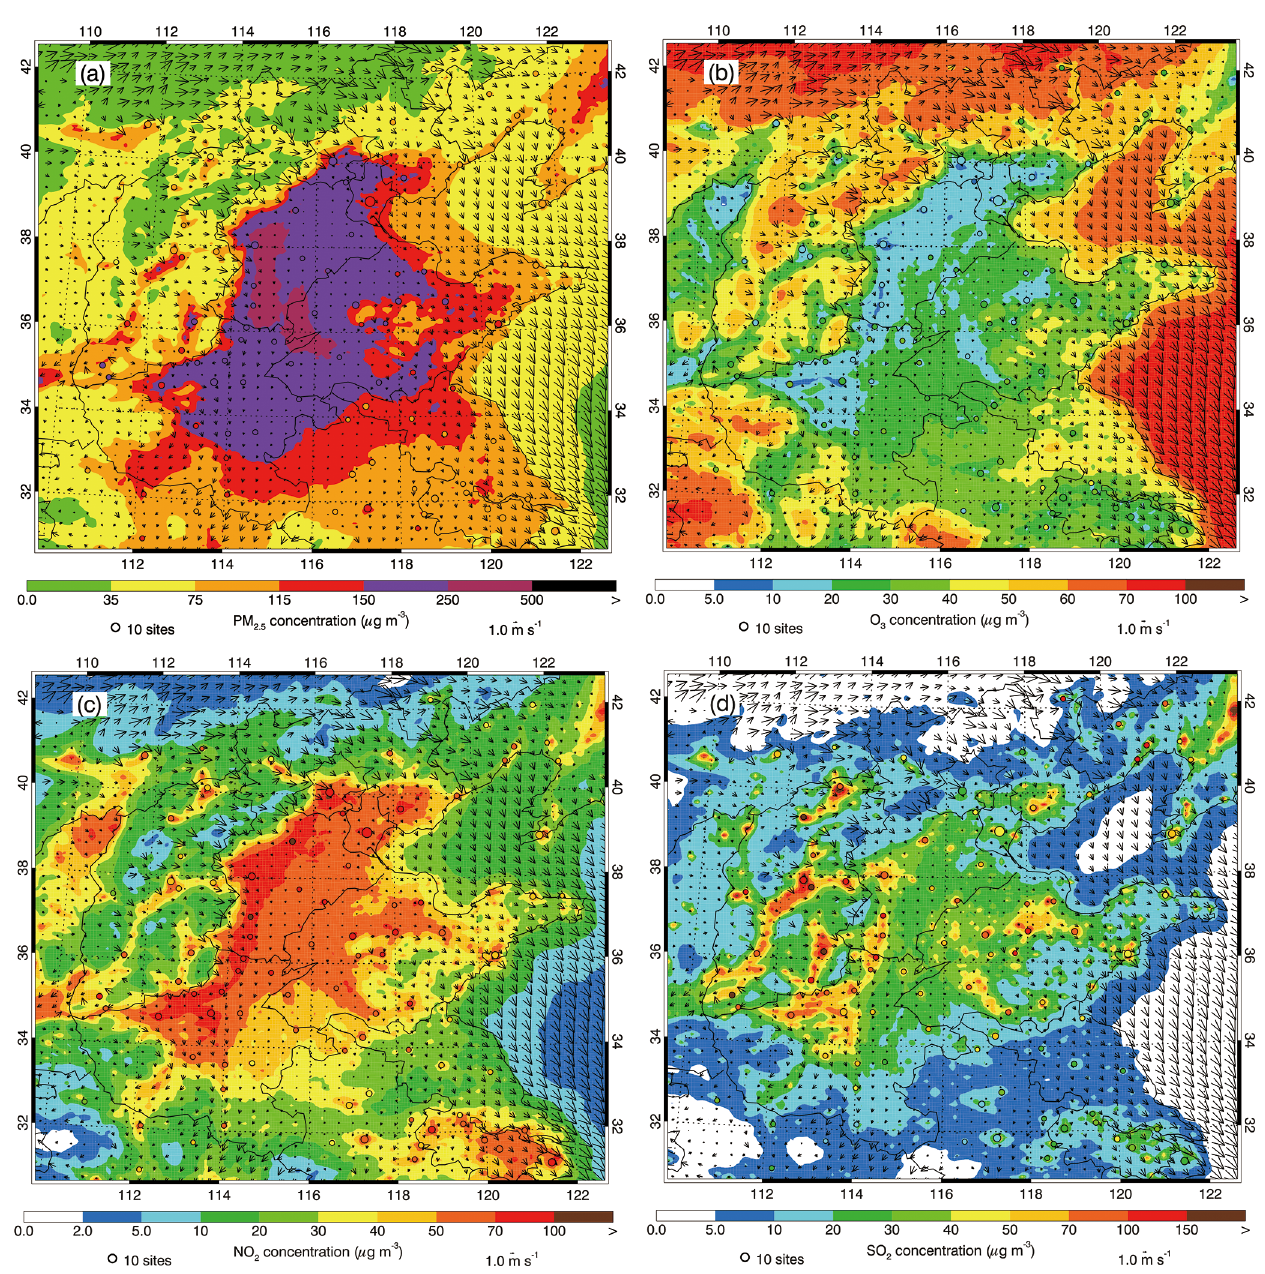
Figure 3. Pattern comparisons of simulated (color contours) vs. observed (colored circles) near-surface mass concentrations of (a) PM 2 . 5 , (b) O 3 , (c) NO 2 , and (d) SO 2 averaged from 5 December 2015 to 4 January 2016. The black arrows indicate simulated near-surface winds.